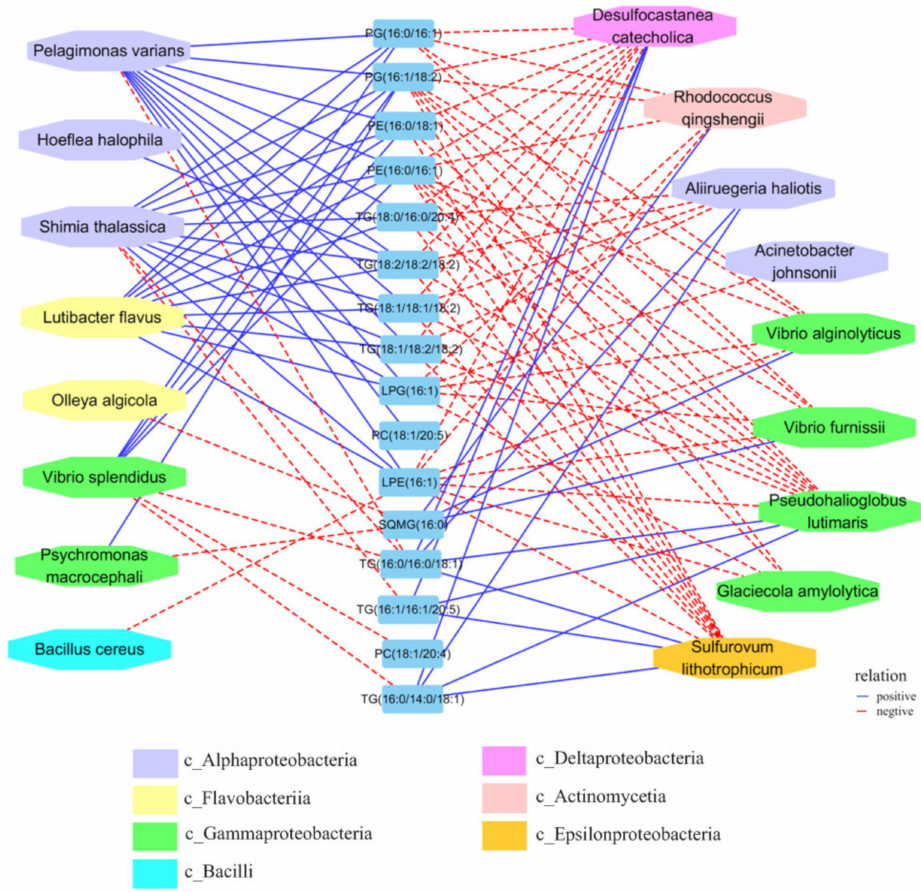
Figure 7. Correlation network analysis of the key lipid metabolites and the major intestinal microbiota throughout the progress of the V. splendidus infection. The solid (or dashed) arrows represent positive (or negative) interactions between the two individual taxa. OTUs are colored to indicate the bacterial class